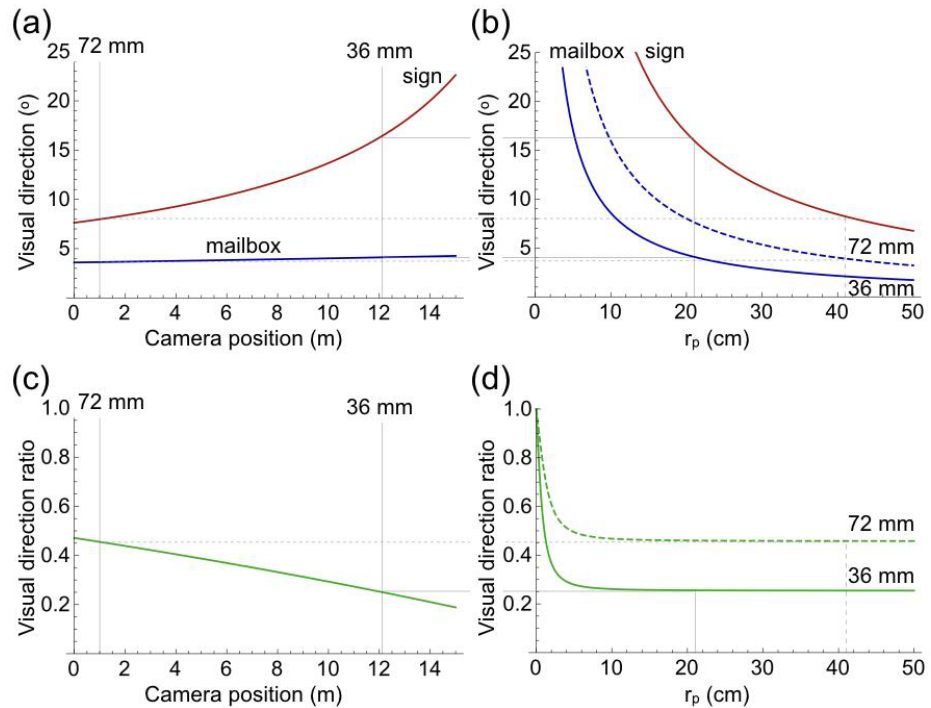
Figure 6. Visual directions. ( a ) Visual directions of the center of the physical 30 km traffic sign standing at the left side of the road (red) and the mailbox of the distant house (blue) as function of camera position. The origin of the camera-position scale is given in Figure 2a. ( b ) Visual directions as function of viewing distance of the picture (r p ). The solid blue line shows the visual direction of the mailbox in the 36 mm picture of Figure 1a, the dashed blue line, of the mailbox in the 72 mm picture of Figure 1b. Thin lines mark the viewing distances at which the visual directions of projected objects are equal to the visual directions of the physical objects (see Figure 2a). ( c ) Ratio between visual directions of the physical house and traffic signs shown in ( a ). ( d ) Ratio between visual directions of the depicted house and traffic signs shown in ( b ). The solid line shows the ratio in the 36 mm picture and the dashed line in the 72 mm